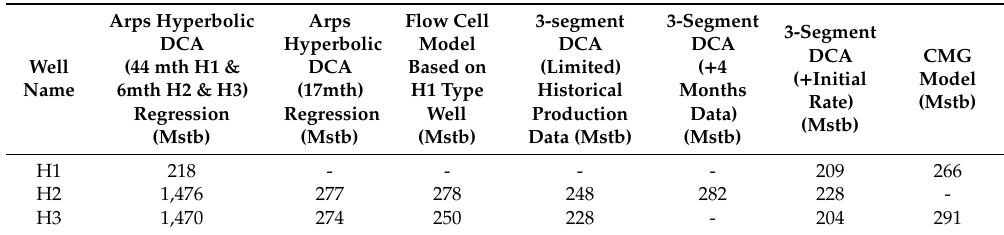
Table 2. Comparison of 30-year estimated ultimate recovery (EUR) estimates for Wells H1, H2, and H3 from various methods.